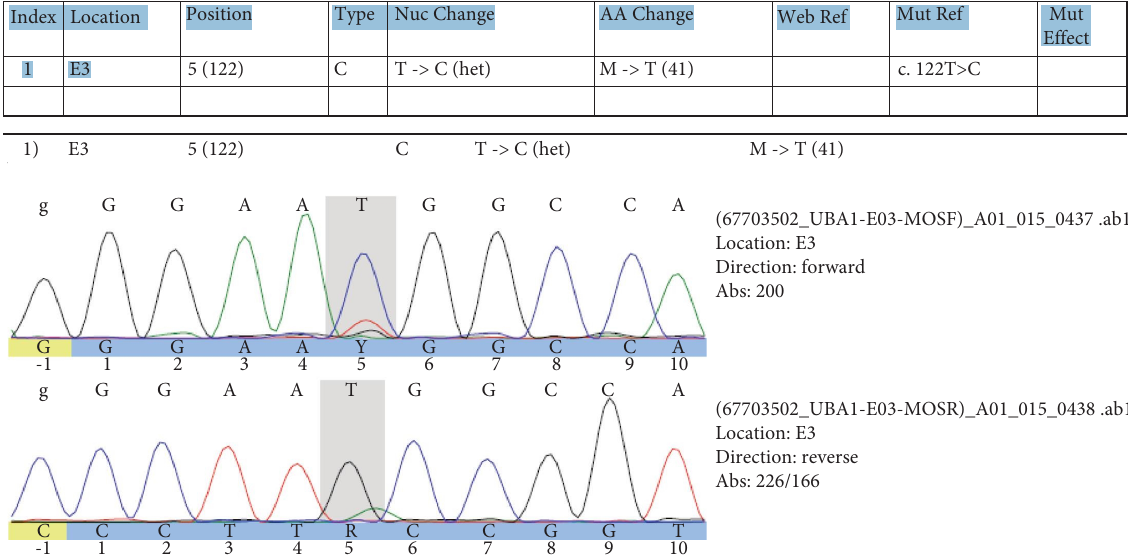
Figure 5: DNA sequencing report illustrating the mutation in the ffth position. Te variant p.Met41Tr exists as the dominant heterogeneity within the VEXAS patient population, and combined with the limited experience, treatment recommen-